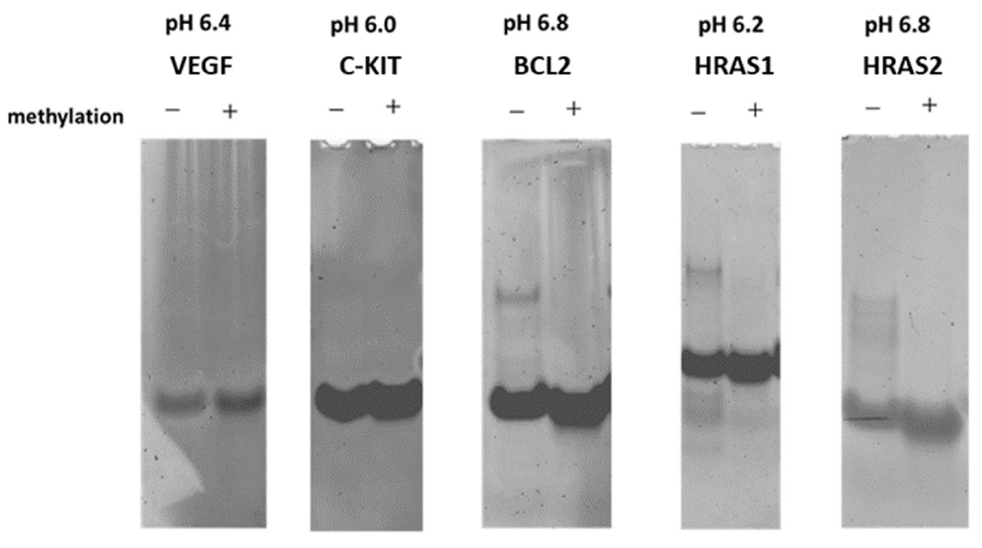
Figure 2. Native-PAGE of the DNAs at each transitional pH of unmethylated i-motifs. The presence (+) and absence ( − ) of CpG methylation (+) is indicated at the top of each lane.